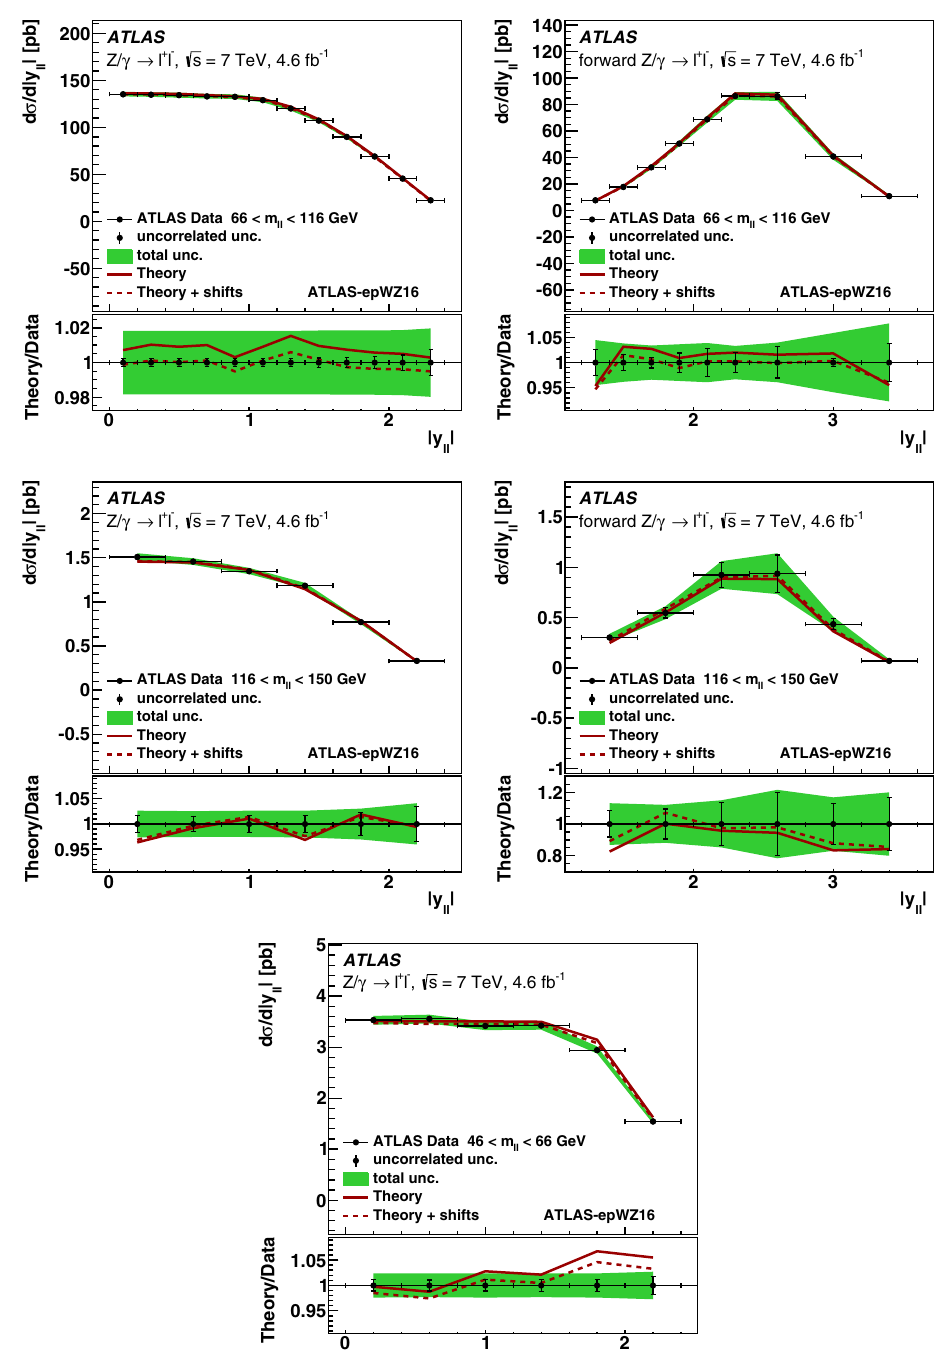
Fig. 29 Differential d σ/ d | y (cid:3)(cid:3) | cross-section measurement for Z /γ ∗ → (cid:3)(cid:3) in the Z -peak region ( upper row ), as well as high dilepton mass m (cid:3)(cid:3) = 116–150 GeV ( middle row ), and low dilepton mass m (cid:3)(cid:3) = 46–66 GeV ( lower row ) compared to the QCD fit result. In the Z -peak region and at high dilepton mass the measurements are s + ¯ s The new determinations of r R s =